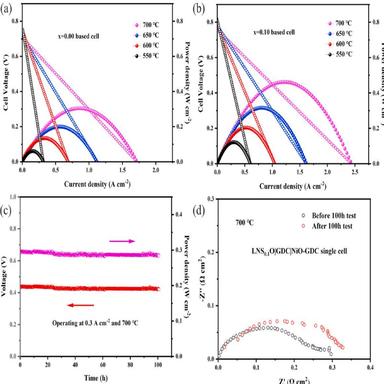
(a–b) I–V–P curves of La2NiO4+δ-based and La2Ni0.9Sc0.1O4+δ-based single cells in the temperature range of 550–700 ◦C (c) long-term stability test curves of La2Ni0.9Sc0.1O4+δ cathode at 700 ◦C (d) EIS of La2Ni0.9Sc0.1O4+δ/GDC/NiO-GDC before and after stability tests.